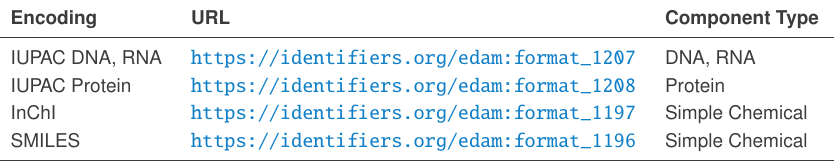
Table 1: URL s for specifying the encoding property of a Sequence , organized by the type of Component (see Table 2) that typically refer to a Sequence with such an encoding .